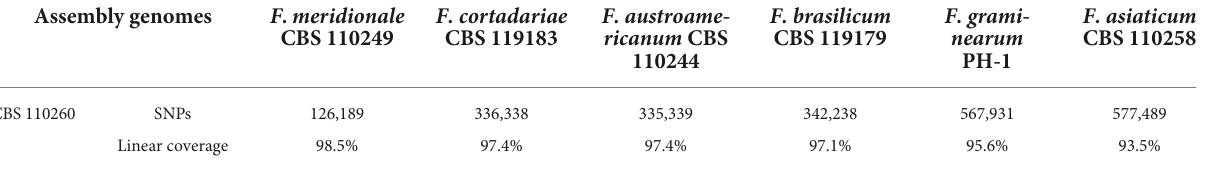
TABLE 1 Results of whole-genome SNP analyses by mapping of assembly genomes to reference CBS 110260 strain. Assembly genomes